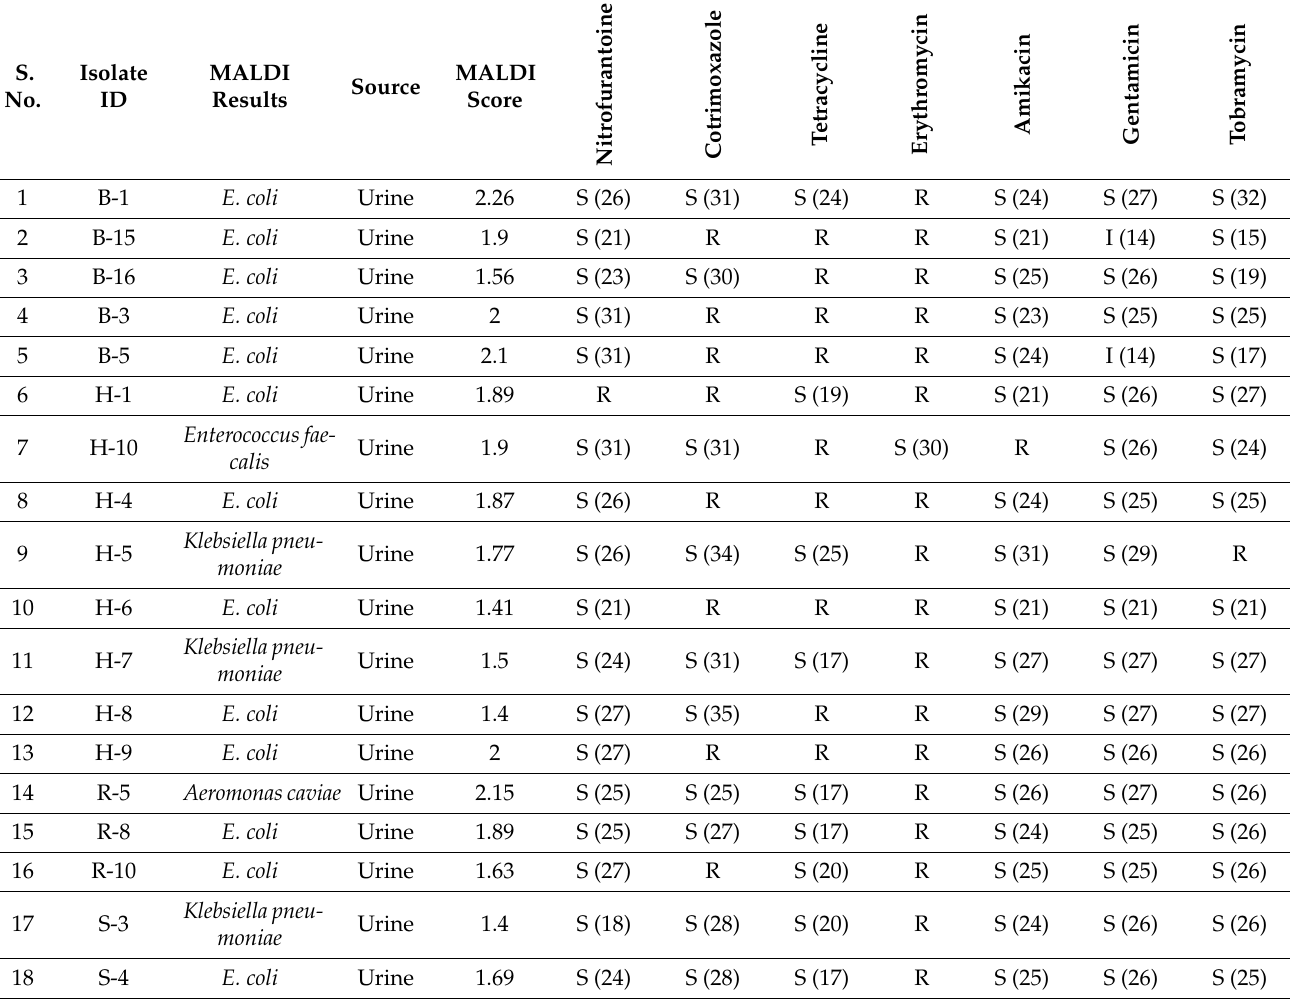
Table 1. MALDI results and Antimicrobial Susceptibility Testing (AST) profile of urine isolates.